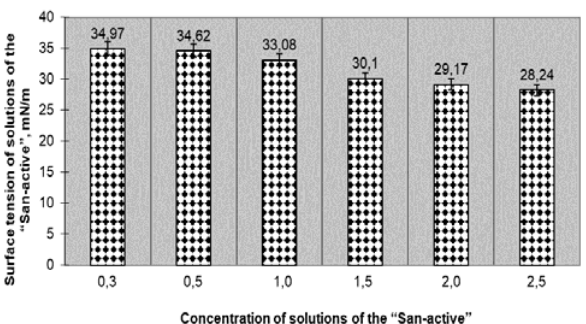
Fig. 2. Surface tension of solutions of the “San-active” depending on its concentration